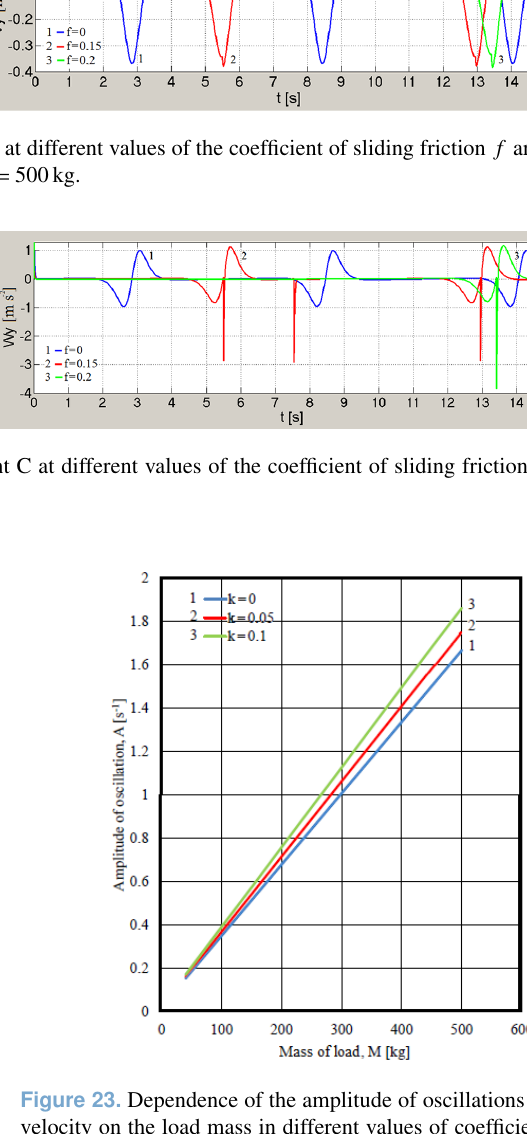
Figure 22. Amplitude-frequency responses of oscillations of angu- lar velocity of the driving link of a mechanism in different values of coefficient of rotational friction and coefficient of sliding friction f = 0.